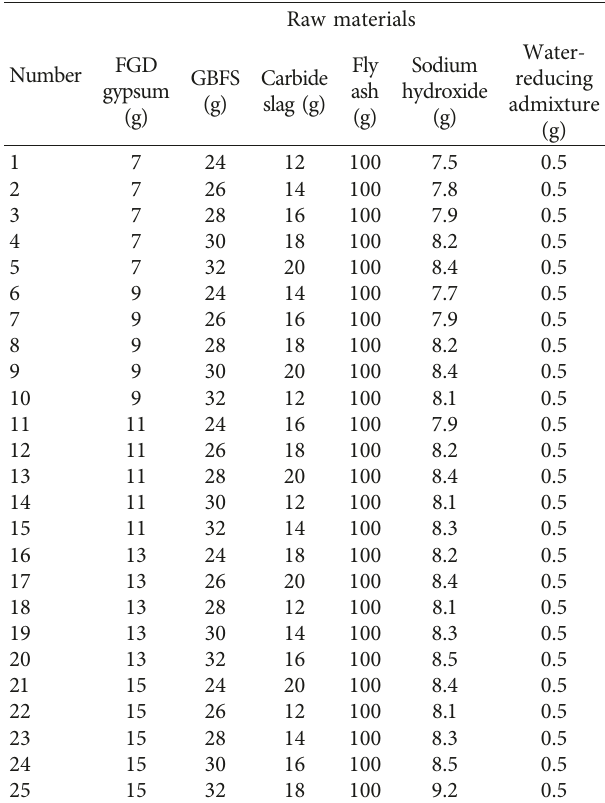
Table 3: Materials proportioning of the orthogonal